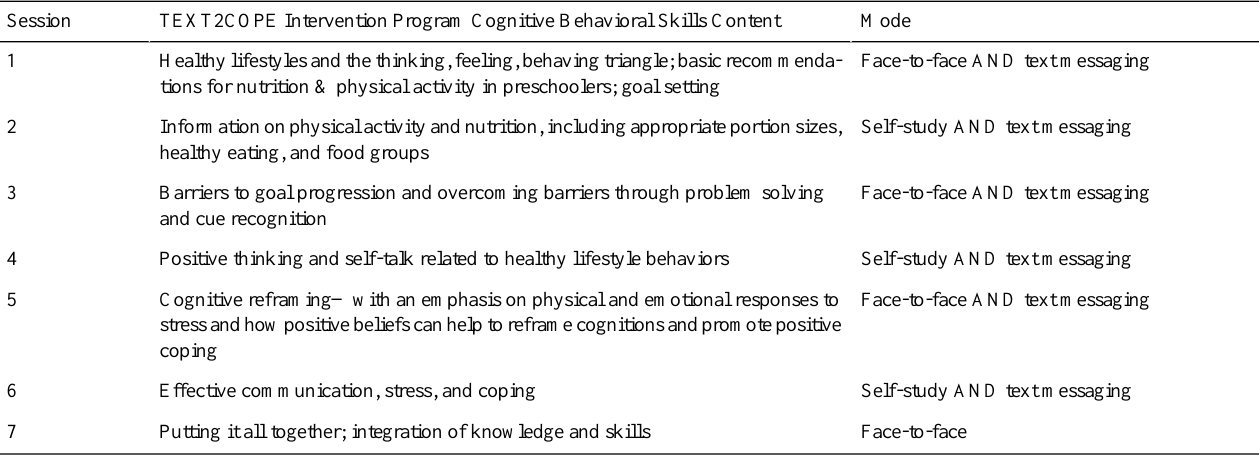
Table 2. TEXT2COPE intervention implementation. ModeTEXT2COPE Intervention Program Cognitive Behavioral Skills ContentSession tions for nutrition & physical activity in preschoolers; goal